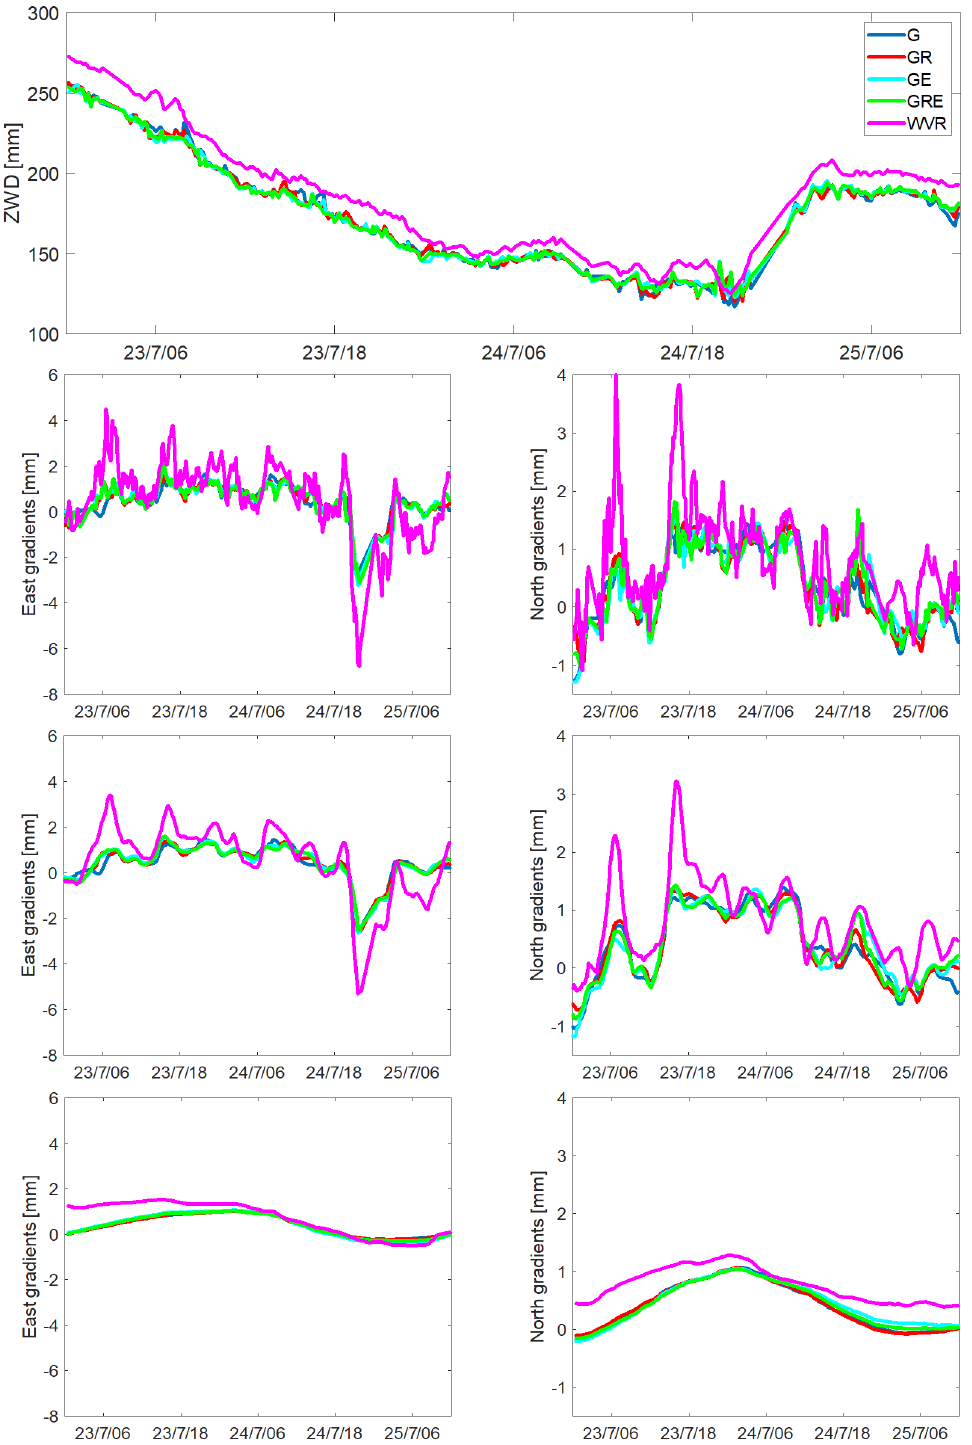
Figure 11. ZWD (top) and gradient time series from the WVR and the GNSS solution using an elevation cutoff angle of 3 ◦ . The east and north gradients are shown in the second, third, and fourth row of graphs for (cid:49)t eff of 5min, 2h, and 24h, respectively. Note the different scales for the east and the north gradient